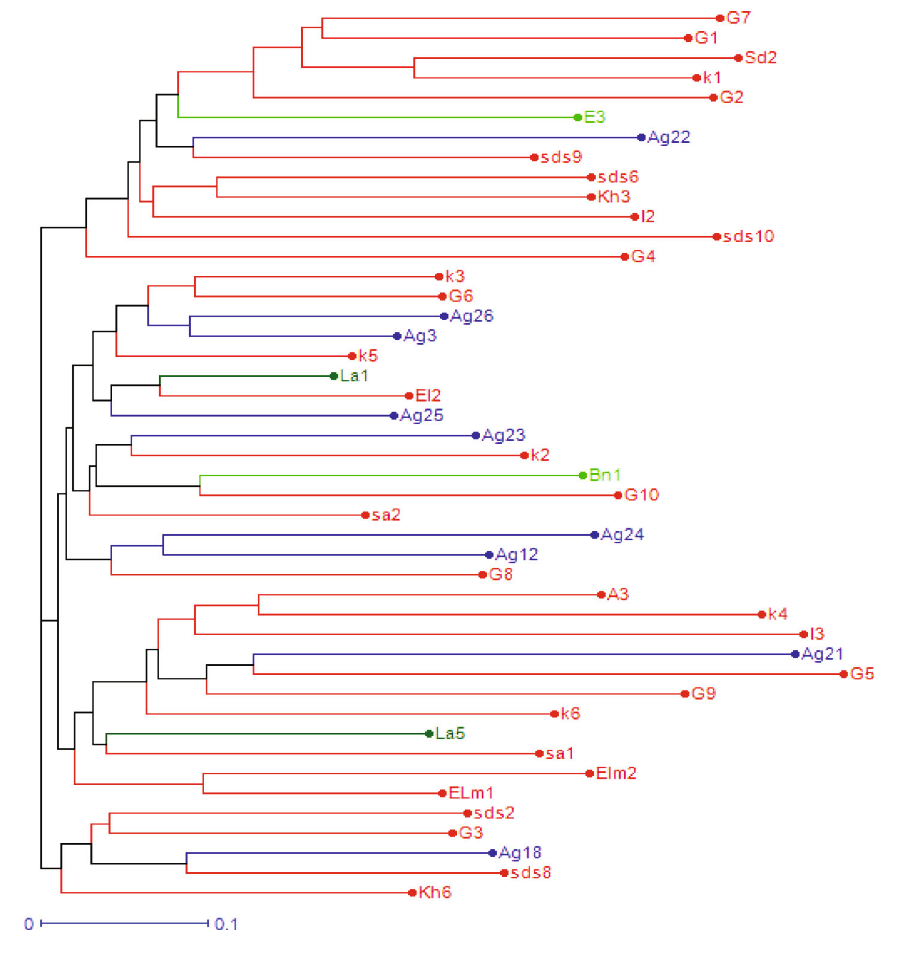
Figure 2: Dendrogram of 45 Alternaria isolates from Citrus collected from seven provinces in Morocco. Unweighted pair group method with arithmetic mean (UPGMA) cluster analysis was based on Jaccard ’ s coe ffi cient. A3, Elm1, Elm2, K1, K2, K3, K4, K6, K5, Kh6, Sa2, Sd2, Sds2, Sds9, Sds10, Sds8, Sds6, Ag3, Ag12, Ag18, Ag22, Ag23, Ag24, Ag25, Ag26, Ag21, and Bn1 — oranges; El2, La5, and La1 — Mandarins; G1, G2, G3, G4, G6, G7, G8, G9, G10, G5, I2, I3, Kh3, and Sa1 — lemons; E3 —